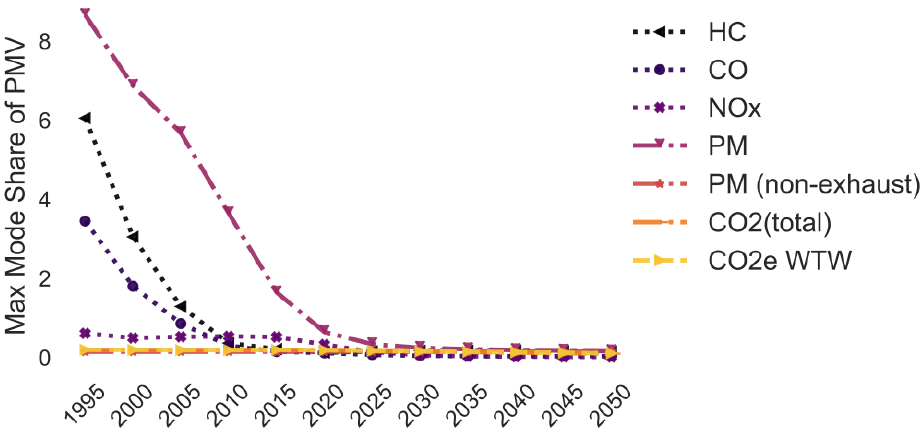
Figure 8. Maximum share of customers who can pick up a parcel by car (varying delivery vehicle stock age) (note: CO 2 (total), CO 2 e WTW and PM 10 (non-exhaust) are the same).